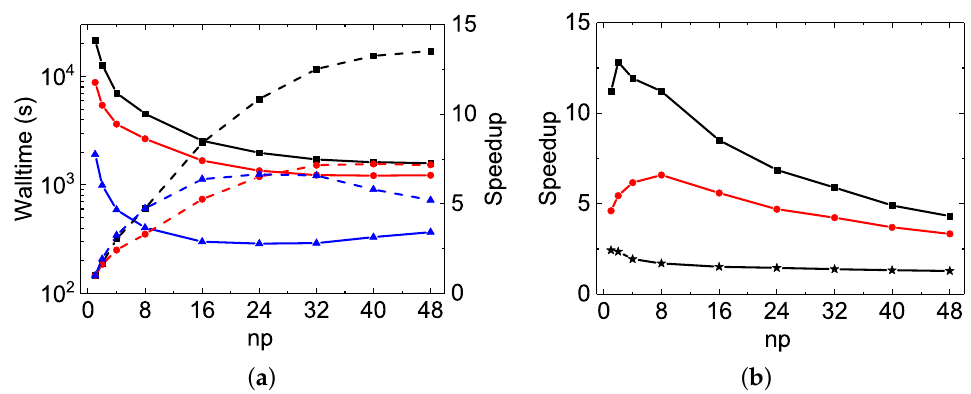
Figure 3. MPI performances for the code running times in the Mg VII AS 3 -SCF calculations. ( a ) Solid (left y axis): walltimes (in s) for rmcdhf_mpi (squares), rmcdhf_mem_mpi (circles), and rmcdhf_mpi_FD (triangles) codes versus the number of MPI processes ( np ). Dashed lines (right y axis): speed-up factors for the three codes, with the same corresponding symbols, estimated from the ratios of T ( np = 1 ) to others. ( b ): Speed-up factors of rmcdhf_mpi_FD relative to rmcdhf_mpi (squares) and to rmcdhf_mem_mpi (circles), respectively. Speed-up factors of rmcdhf_mem_mpi relative to rmcdhf_mpi (stars).